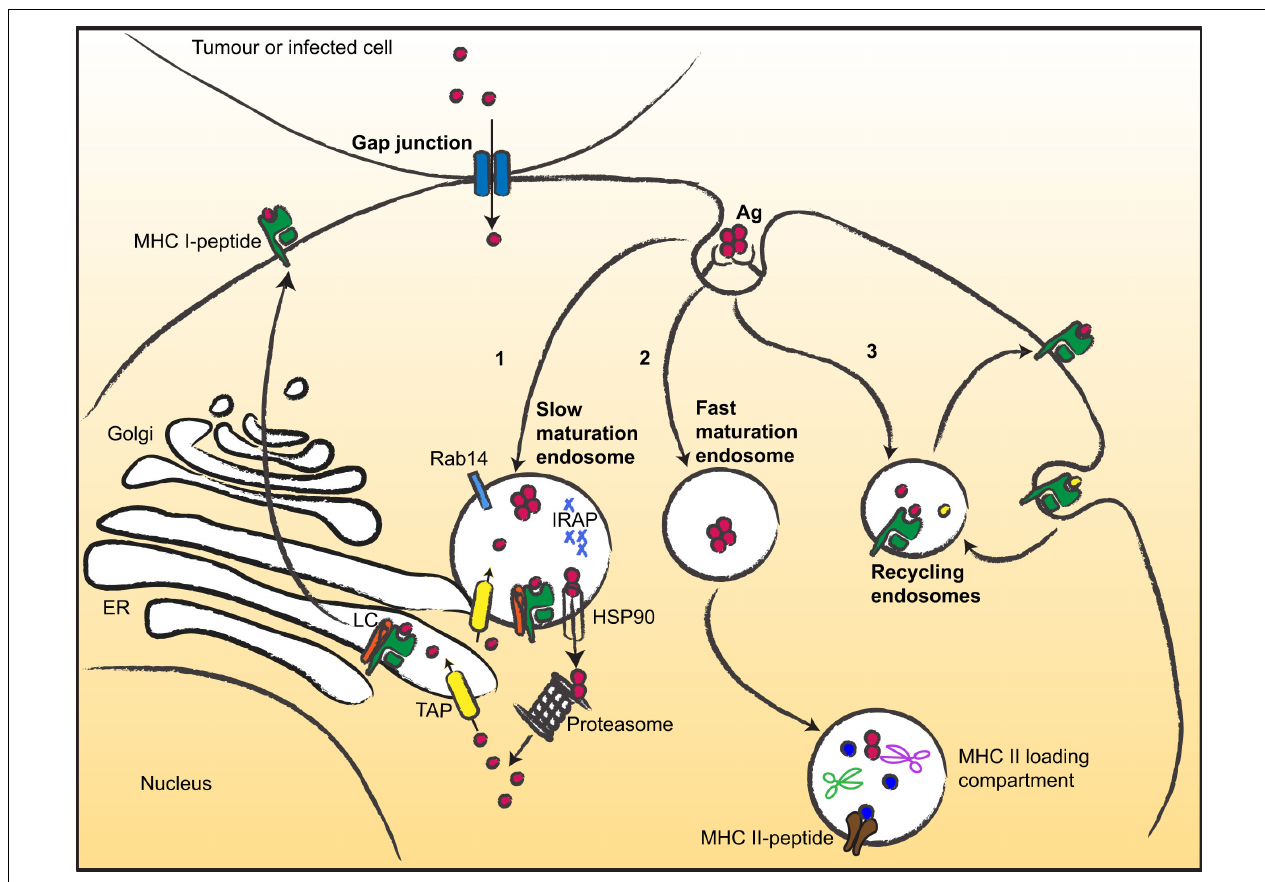
compartment for loading; (2) Fast maturating endosomes, addressing the antigens to low pH- and high proteolytic- compartments suited for MHC II antigen presentation; (3) Recycling endosomes, where loading occurs on recycling MHC I molecules. Gap junctions mediate transfer of small peptides between neighboring cells. LC, loading